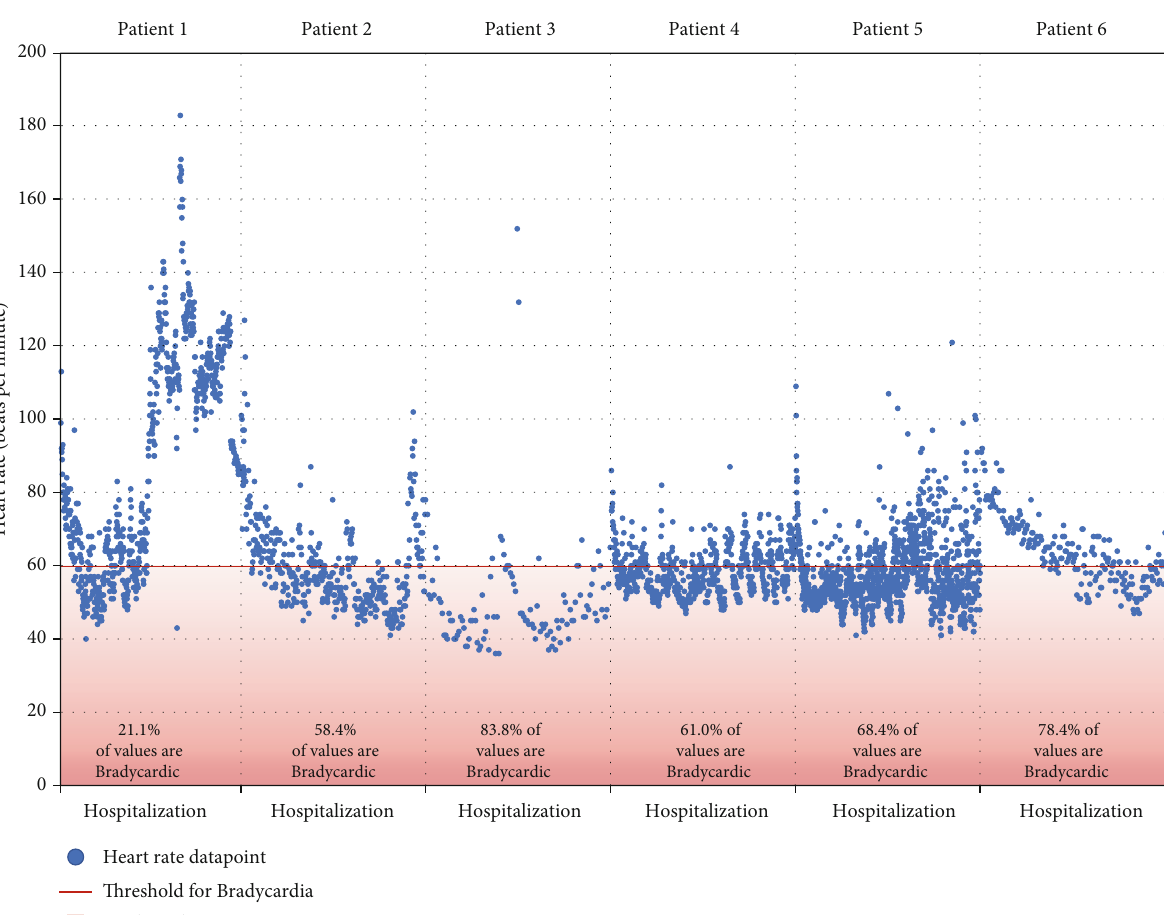
Figure 1: Heart rate throughout hospitalization for each patient. Every discrete heart rate datapoint as recorded in the electronic medical record throughout each patient ’ s hospital stay, with patients ’ data shown adjacent to one another using a uniform y -axis, but individually labeled x -axes. The proportion of recorded values found to be bradycardic is noted at the bottom of each patient ’ s dataset. HR: heart rate; %: percentage; x -axis: duration of hospitalization (continuous measure of time, no discrete intervals used); y -axis: heart rate in beats per